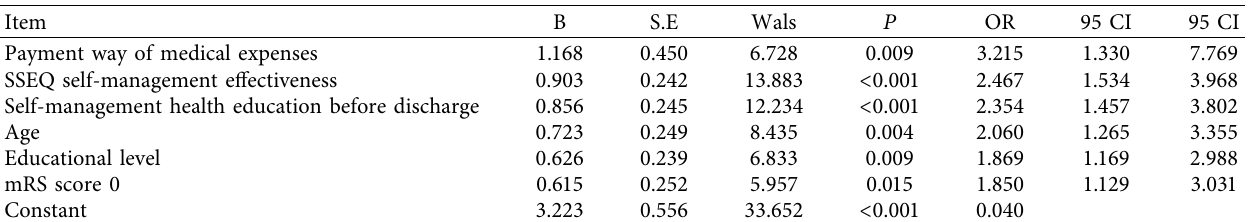
Table 7: Te multifactor analysis of stroke self-management behavior in 354